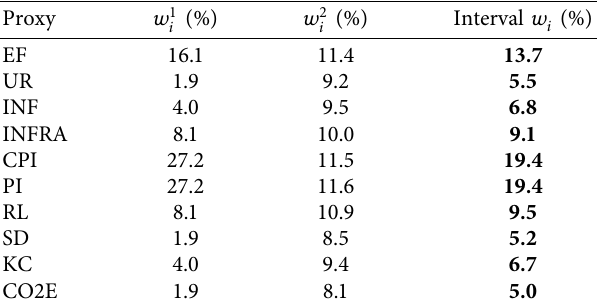
Figure 5: Illustrating the midpoint between the fuzzy weights and the expert weights. Table 15: Computing the interval